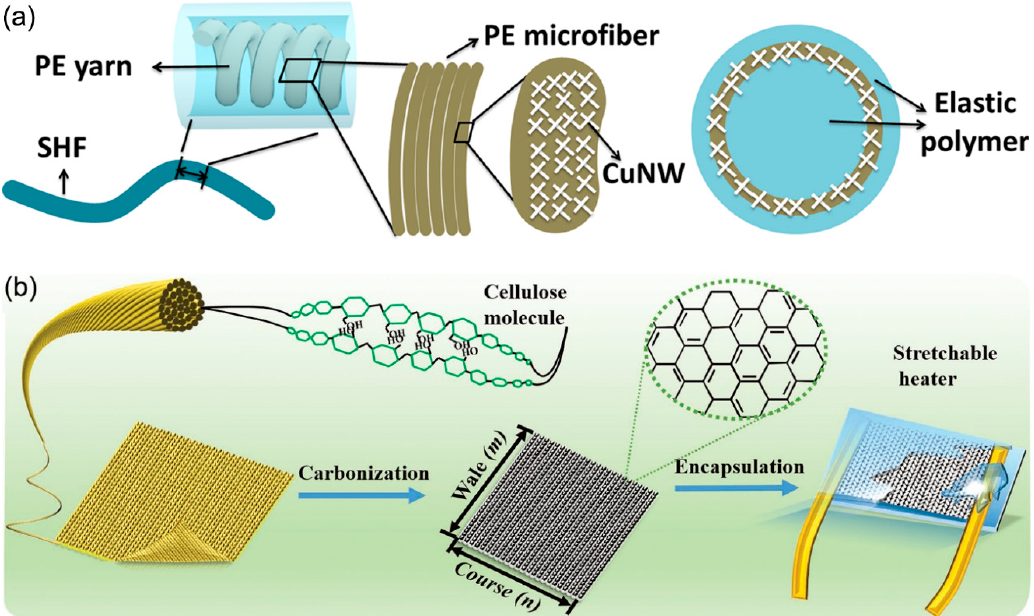
Figure 14. ( a ) Schematic illustration of the hierarchical structure of the SHF. Reproduced from